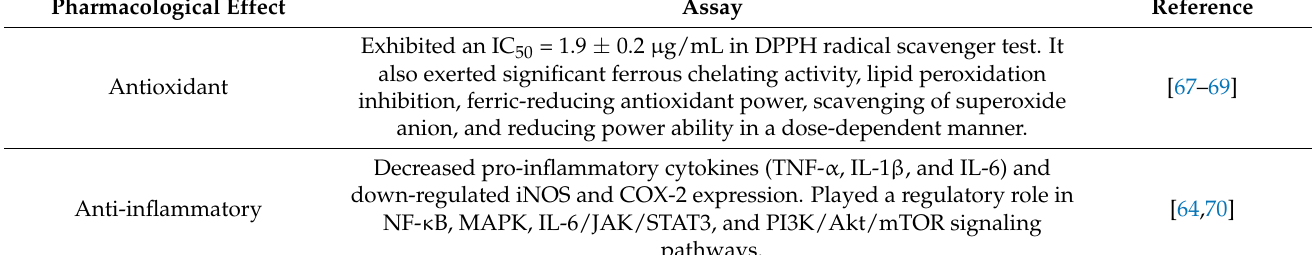
Table 2. Principal pharmacological properties of punicalagin, the major active compound in P. granatum . Pharmacological